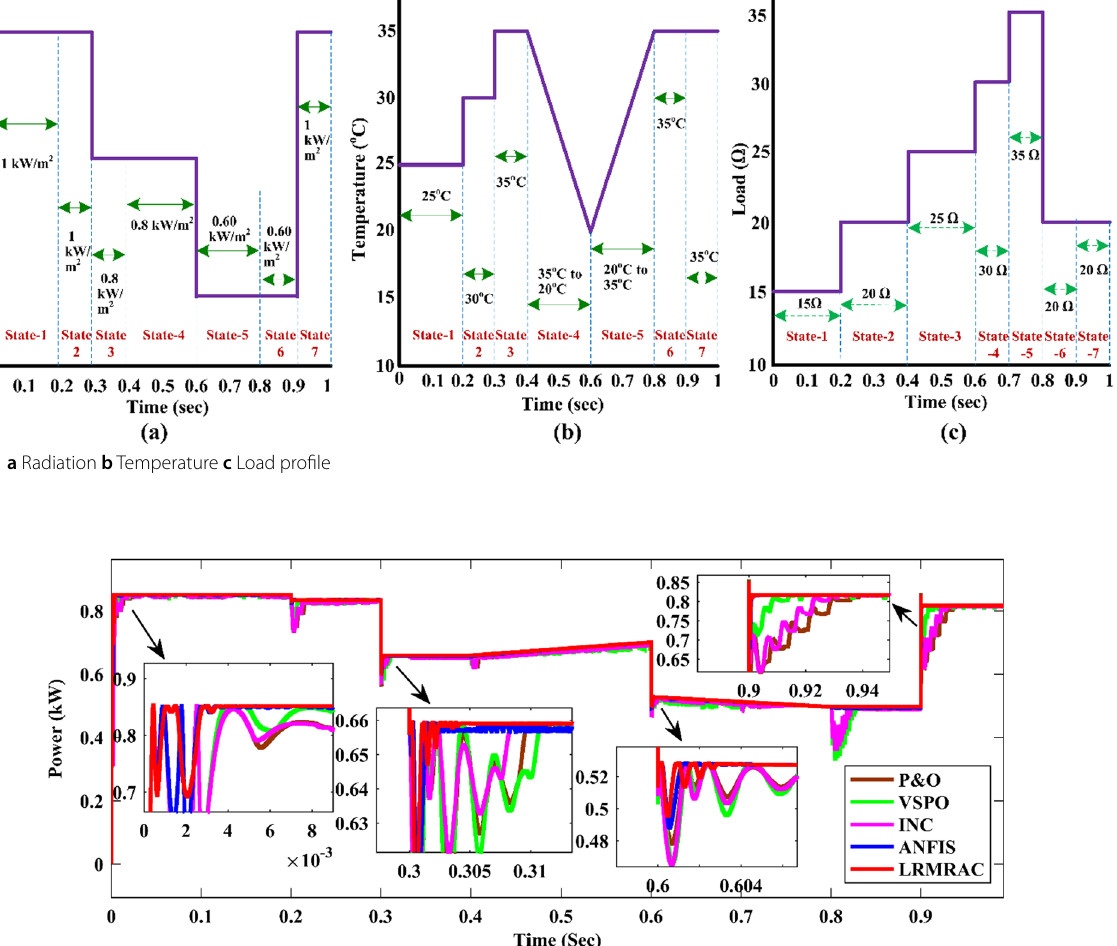
Fig. 13 PV power using the five MPPT algorithms while temperature, irradiance, and load all change at